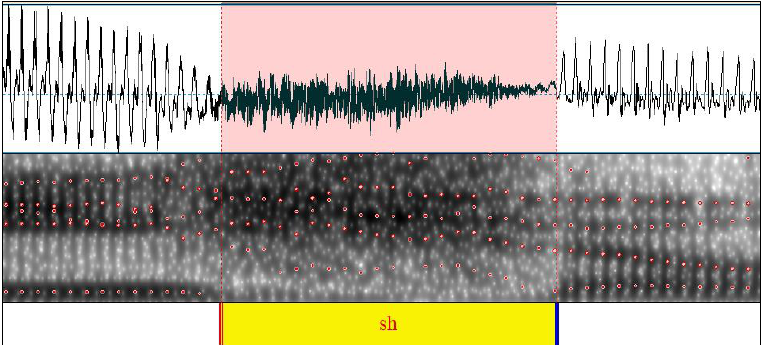
Figure 4. Coding of [ ʃ ] in the word bicho “ bug ” . Female speaker (UT030). The audio for this example is available at